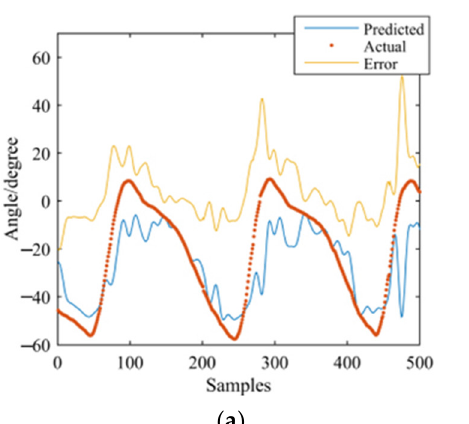
Figure 16. Prediction results of hip-joint angle in the going downstairs process. ( a ) Results of IN1; ( b ) Results of IN2; ( c ) Results of IN3.